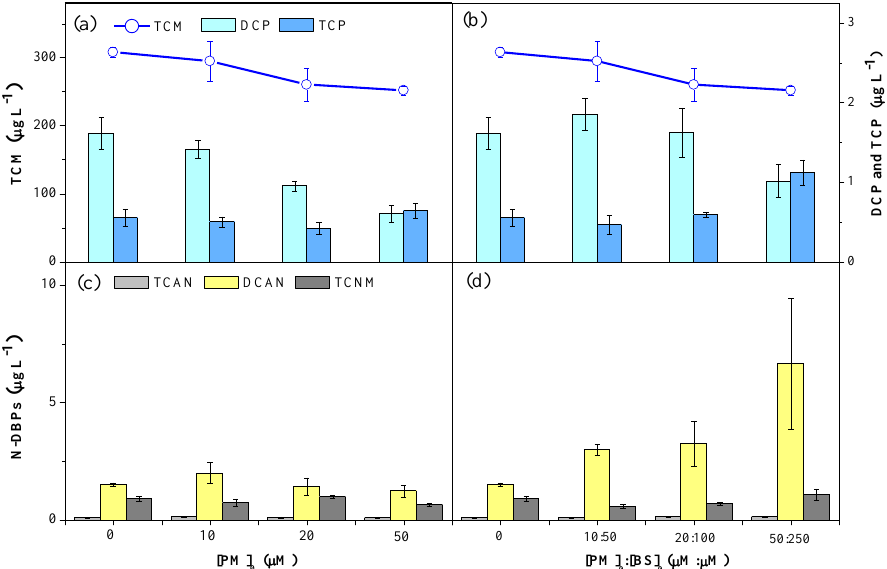
Figure 4. Effect of PM ( a , c ) and PM/BS ( b , d ) doses on the formation potential of C-DBPs and N- ((HA) o = 3 mg L − 1 , (PM) o = 0–50 µ M, (BS) o = 0–250 µ M and t = 30 min). Duplicated samples DBPs. ((HA) o = 3 mg L − 1 , (PM) o = 0‒50 μM, (BS) o = 0‒250 μM and t = 30 min). Duplicated samples were were analyzed.